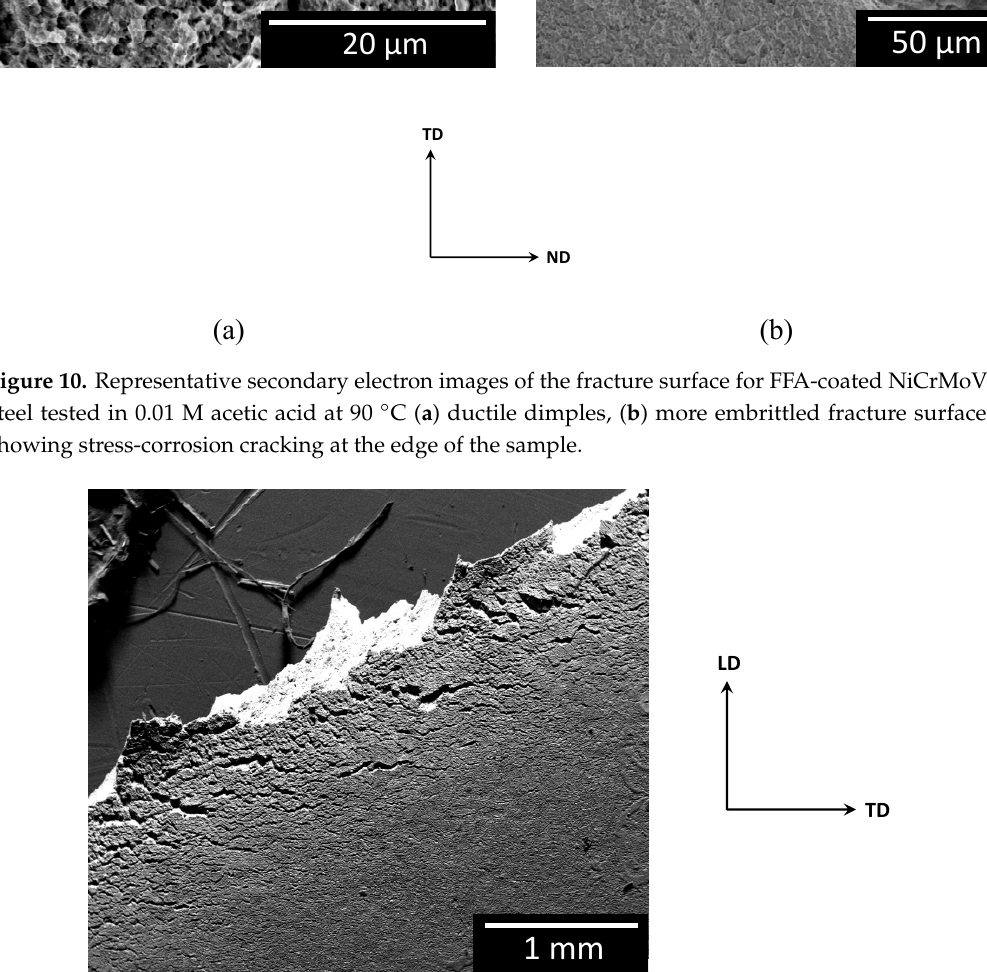
Figure 11. Representative secondary electron image of the top surface for FFA-coated NiCrMoV steel tested in 0.01 M acetic acid at 90 °C.